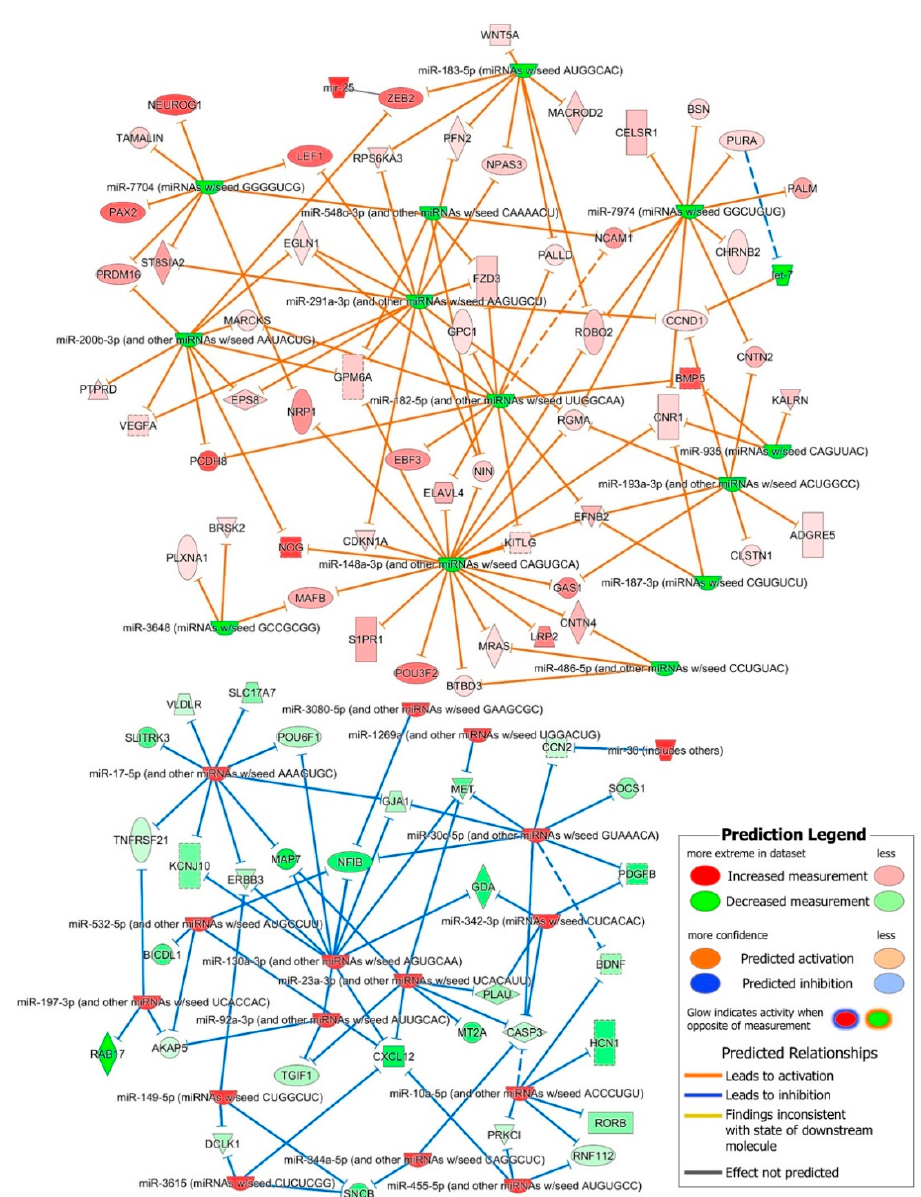
Figure 4. miRNA–mRNA interaction network showing interactions between 85 DE mRNA enriched in significantly upregulated human nervous system development functions and miRNAs found DE between iPSCs and differentiated NSCs.